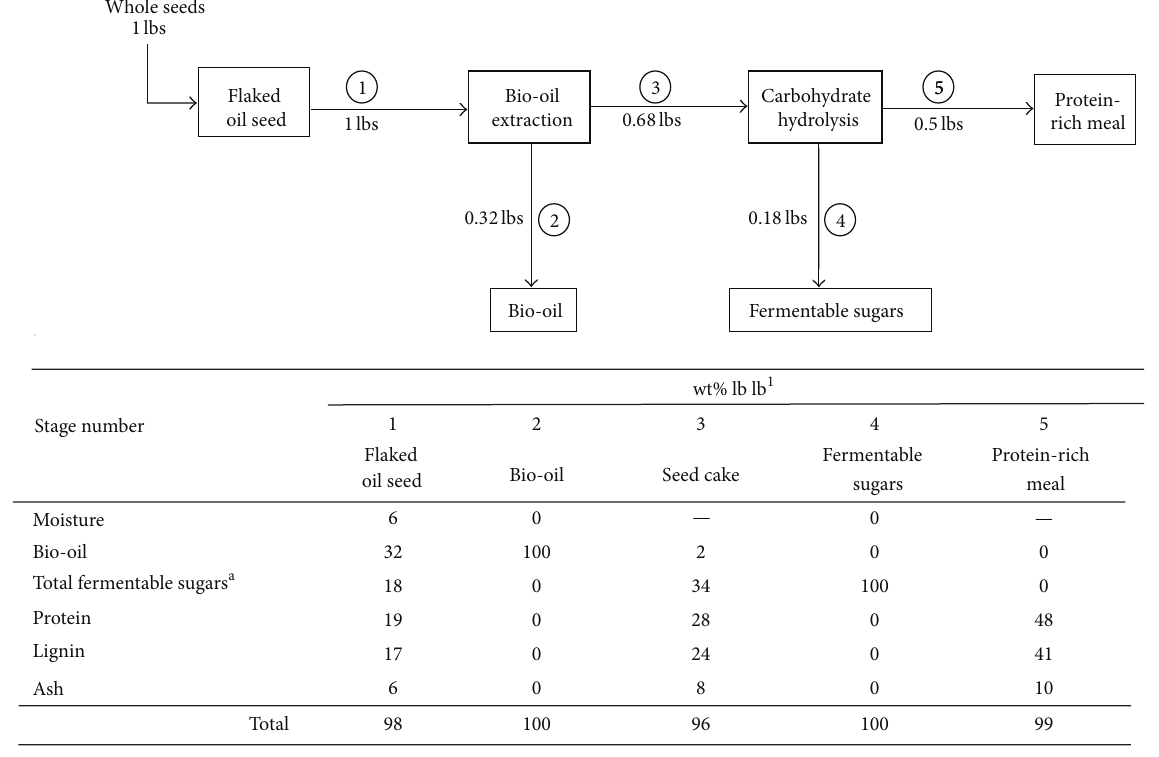
Figure 6: Mass balances for solvent extraction of jatropha whole seed and composition of the intermediate stages. Whole jatropha seed taken to comprise moisture (6%), bio-oil (32%), total fermentable sugars (18%), protein (19%), lignin (17%), and ash (6%). The values in the tables are averages taken from the literature and consequently do not always sum to precisely 100